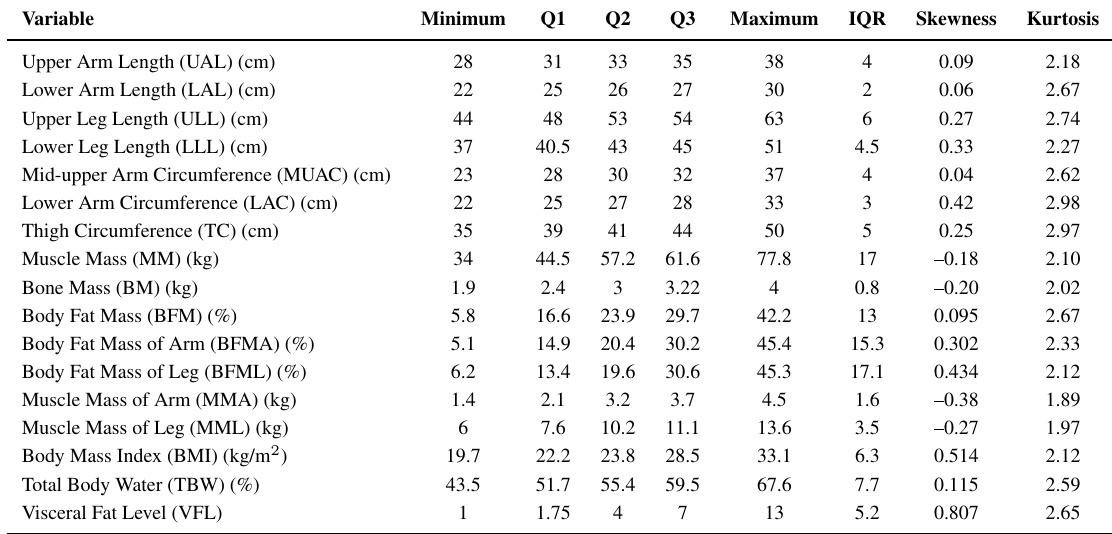
Table 1. Descriptive statistics of anthropometric and body composition